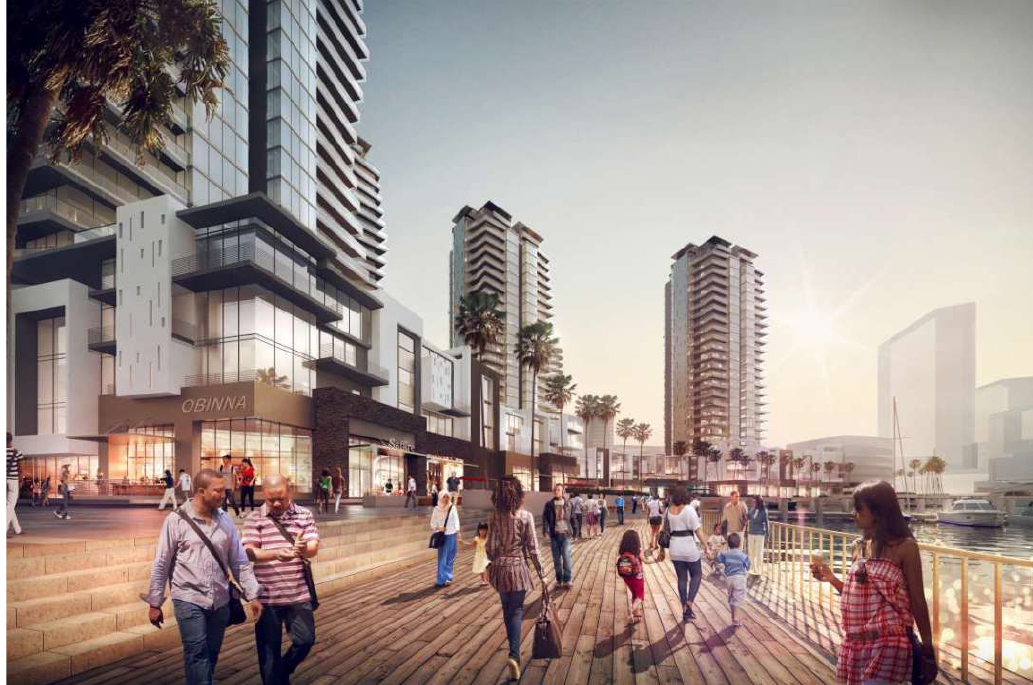
Figure 2. A rendering of the marina for Eko Atlantic. Source: BBB International (2014). Urban Planning, 2022, Volume 7, Issue 3, Pages